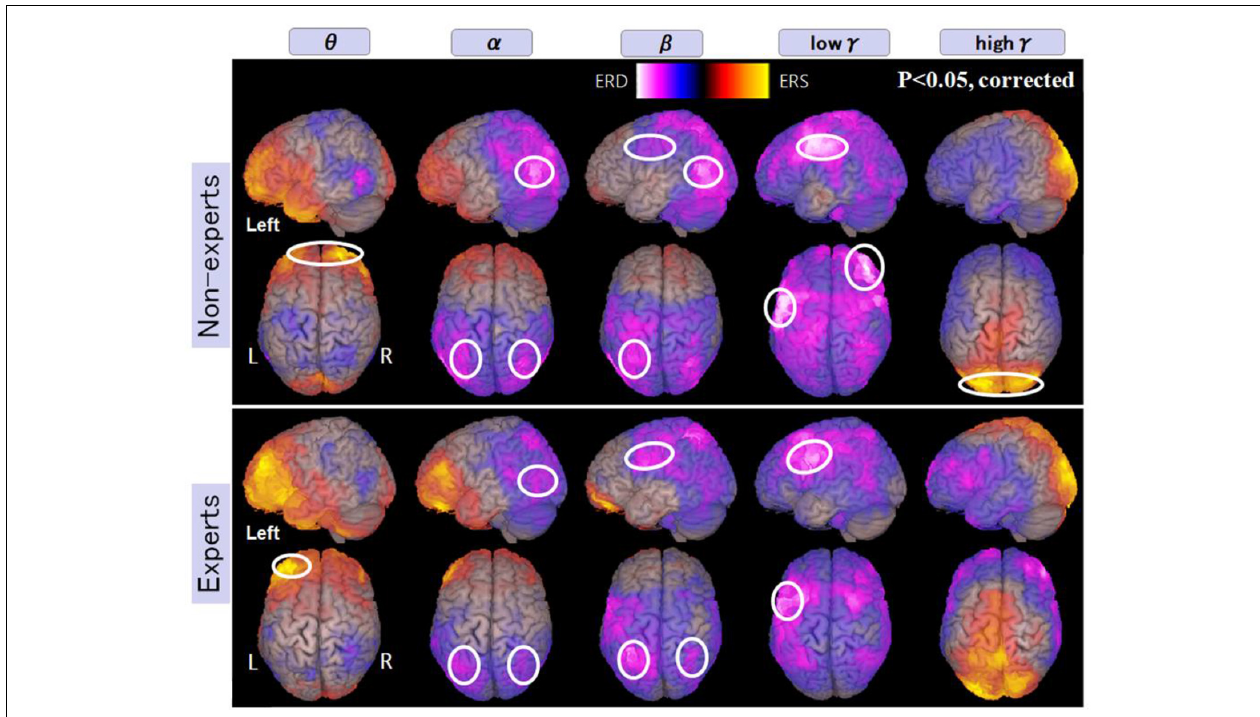
FIGURE 5 | A group average of the spatial distribution of oscillatory changes for the first experiment (mental addition during calculation task). The time window is between − 1,000 and 1,000 ms. The frequency interval (all frequency bands) ranges from 4 Hz to 100 Hz. Magenta color shows ERD and orange color shows ERS. The circled areas indicate statistically-significant oscillatory changes. The significant differences observed ( p < 0.05, corrected) in some brain areas are surrounded by a white circle.